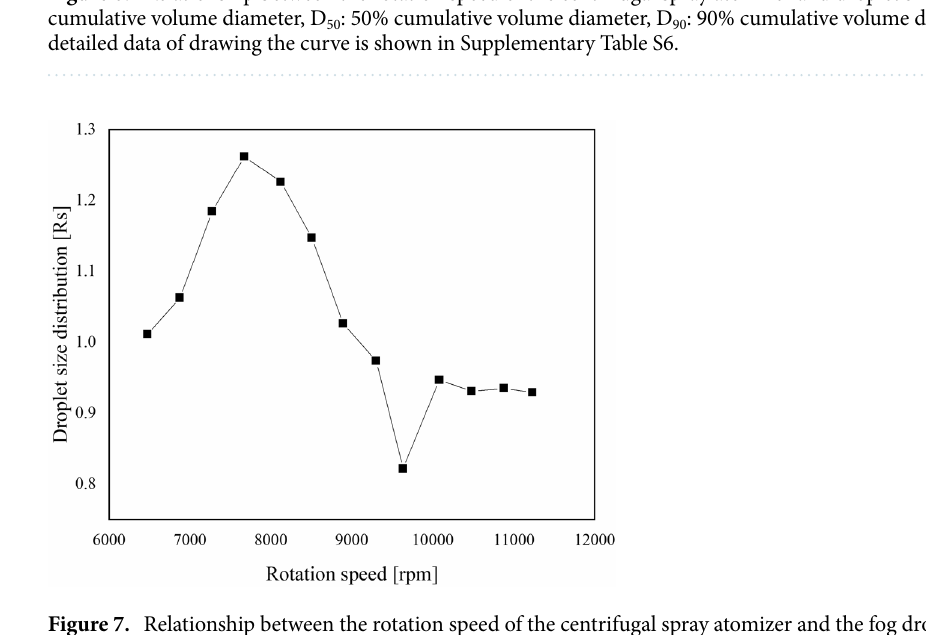
Figure 7. Relationship between the rotation speed of the centrifugal spray atomizer and the fog droplet spectrum. The detailed data of drawing the curve is shown in Supplementary Table S6.